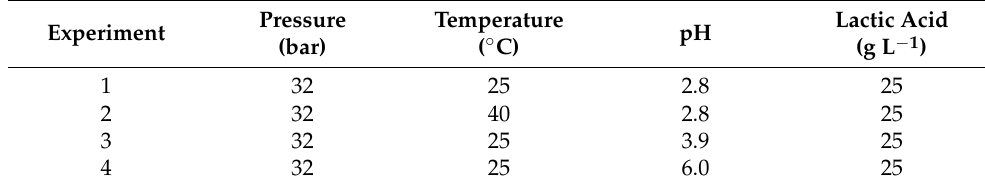
Table 3. Experimental conditions for lactic acid